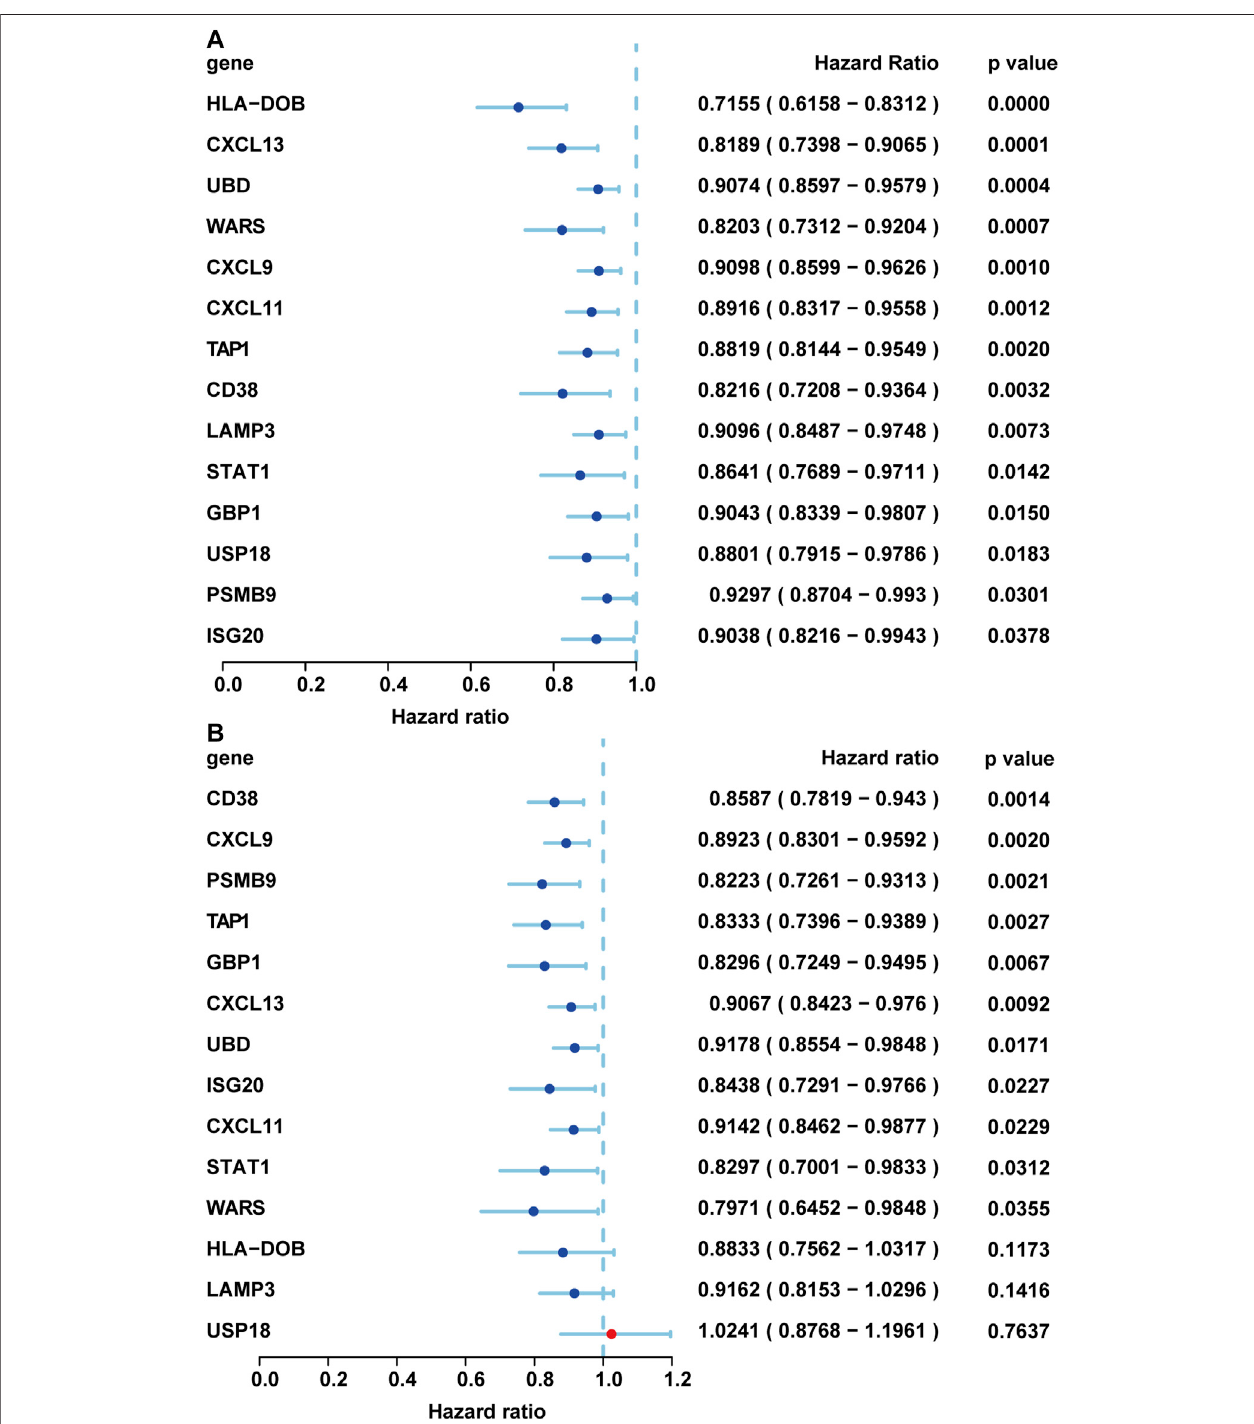
FIGURE 7 | Validation in the TCGA and GEO databases. The prognostic veri fi cation results of each gene were displayed through the forest plot. (A) Internal veri fi cation by TCGA database. (B) External validation by GSE 32062 pro fi le. These genes were sorted by p -value.